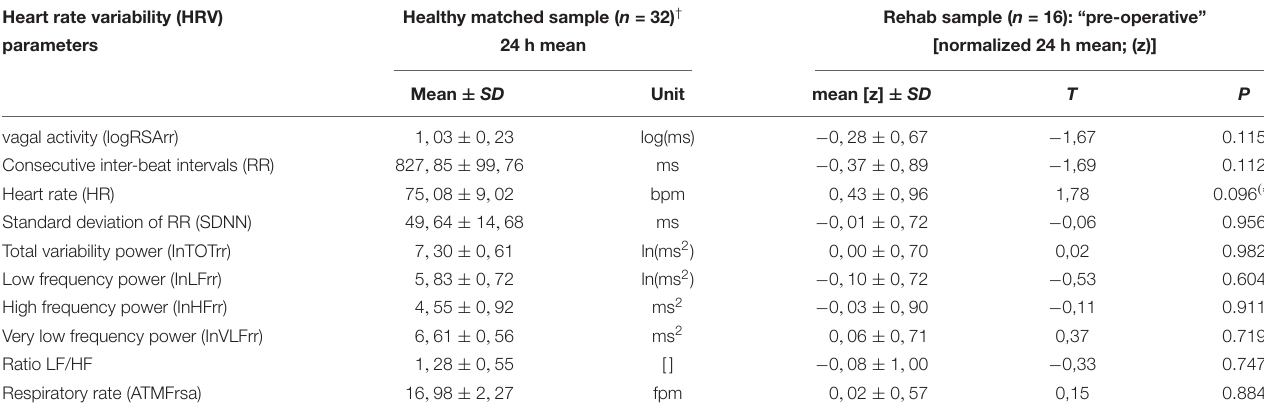
TABLE 4 | Age and gender matched reference values for pre-operative HRV parameters. Heart rate variability (HRV) Healthy matched sample ( n = 32) † Rehab sample ( n = 16): “pre-operative”